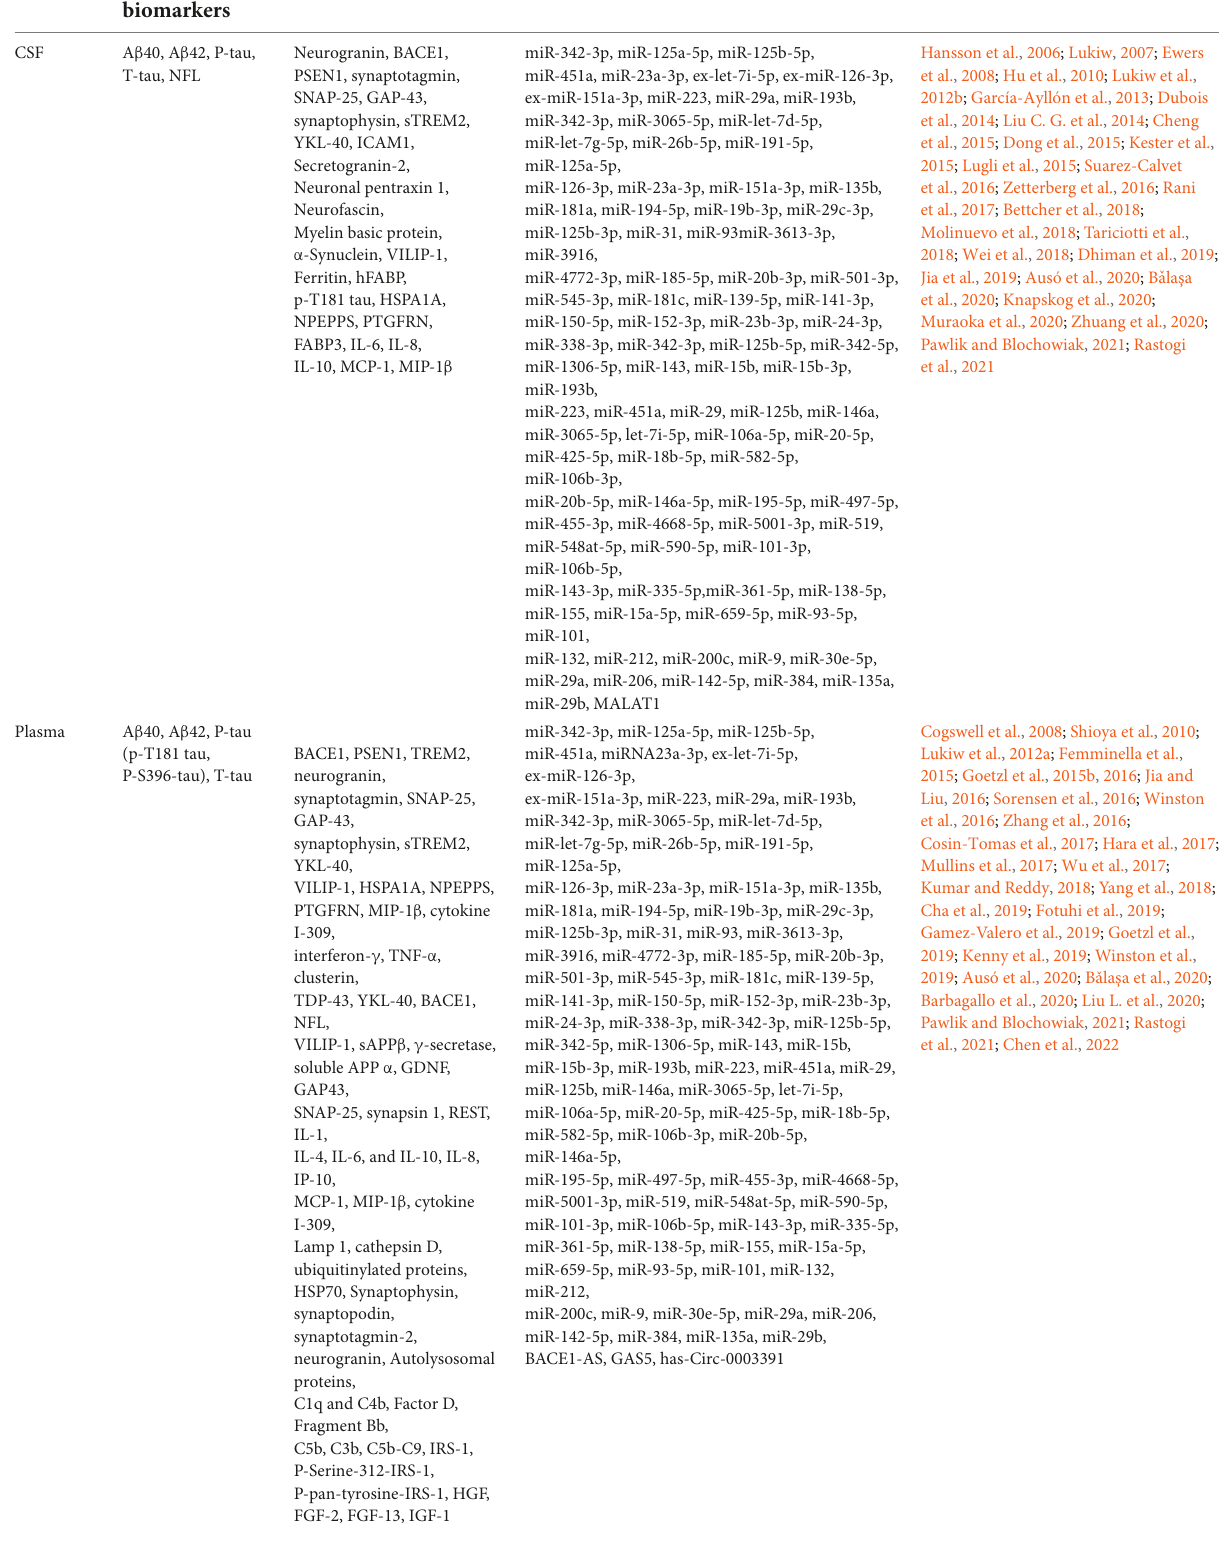
TABLE 1 Statistics of biomarkers in saliva, CSF, blood, Serum, and